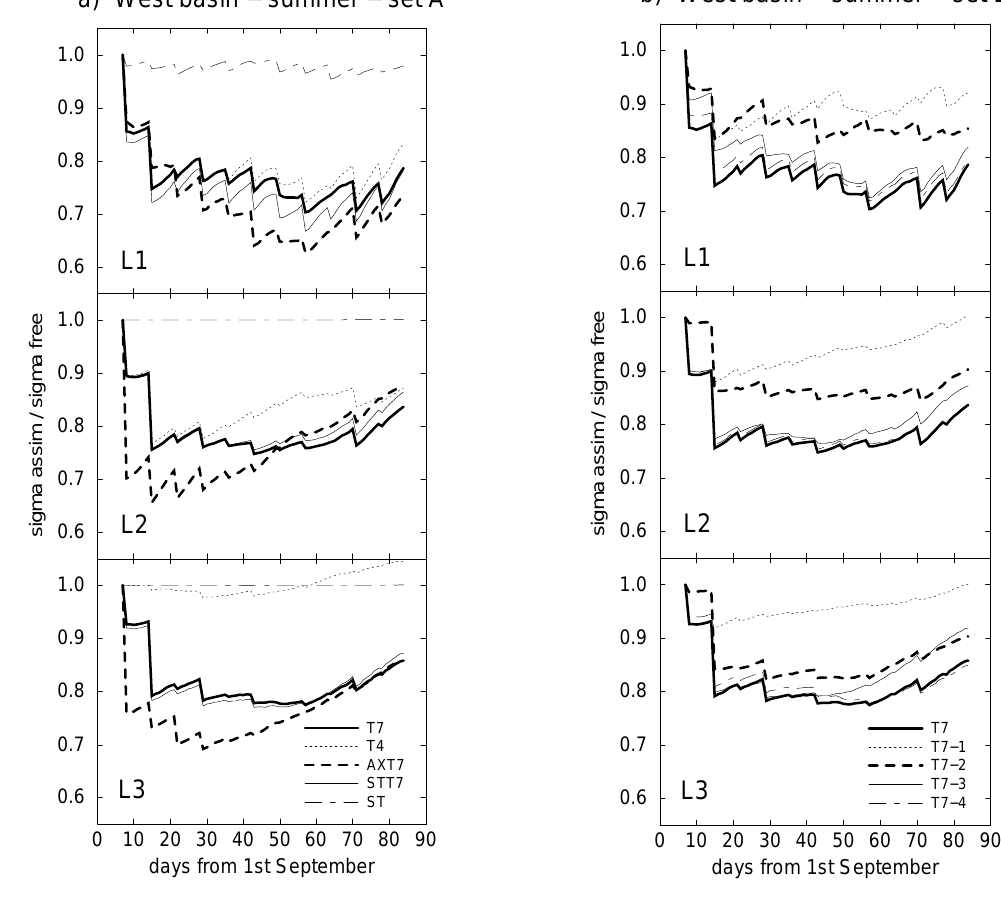
Fig. 5. Time series of temperature relative errors for the western basin in the summer OSSEs with sampling strategies of set A (a) and set B (b) . L1 indicates the surface layer, L2 the intermediate layer and L3 the deep layer.